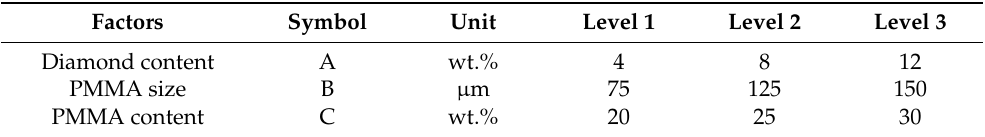
Table 2. Control factors (process parameters) and their levels.